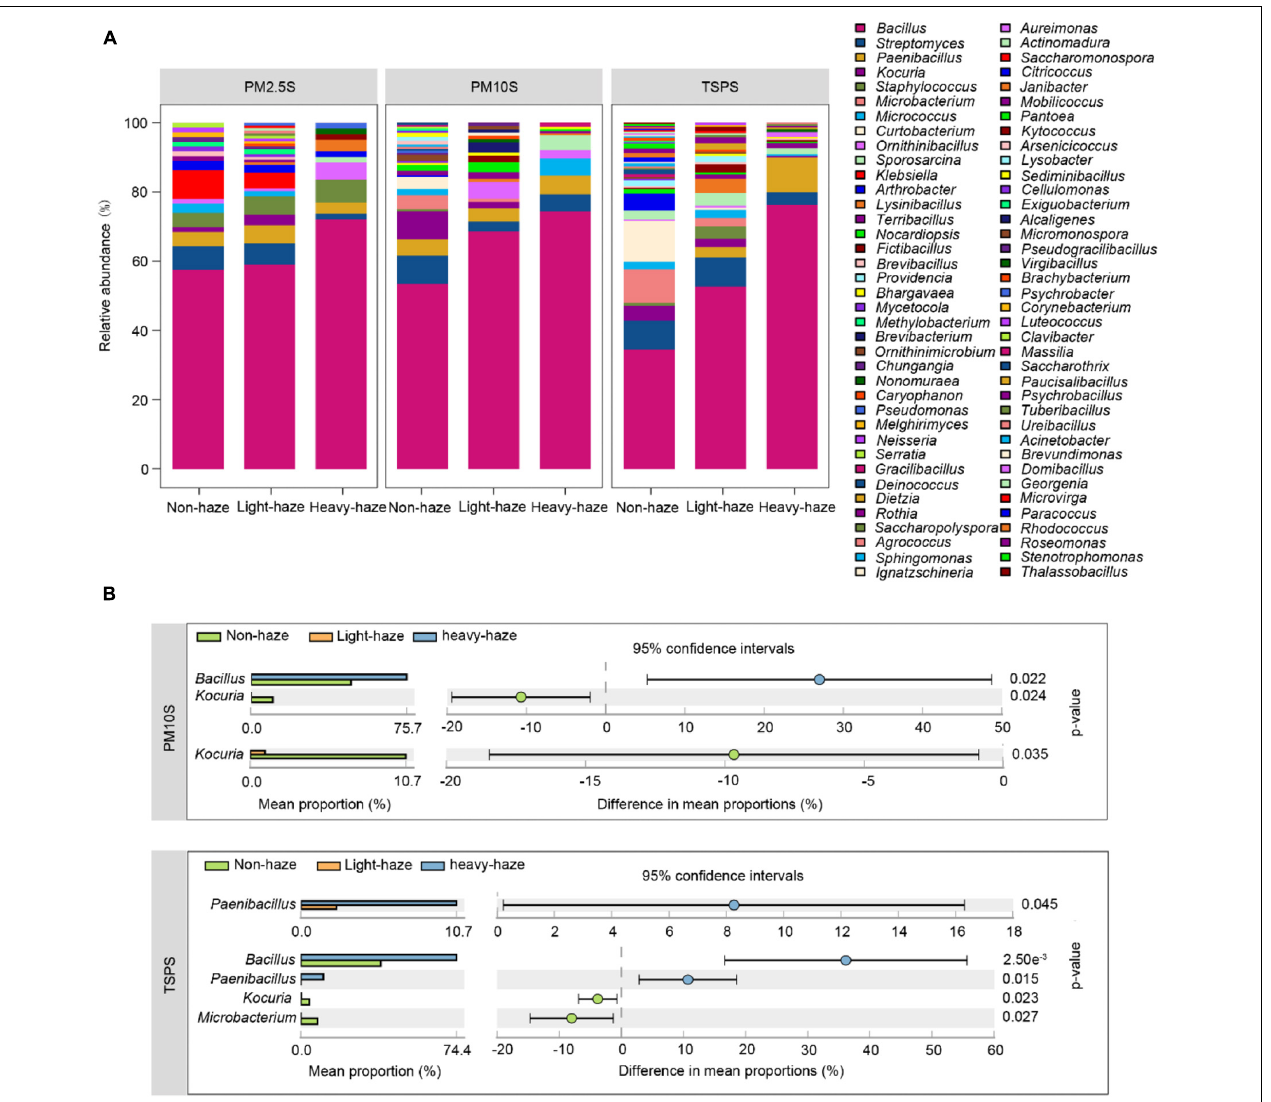
FIGURE 4 | Bacterial diversity and composition among various PMs during non-, light-, and heavy-haze days. (A) Bar plot indicating relative abundances of bacterial genera among PMs. (B) STAMP analysis indicated genera that were significantly different among various haze-level